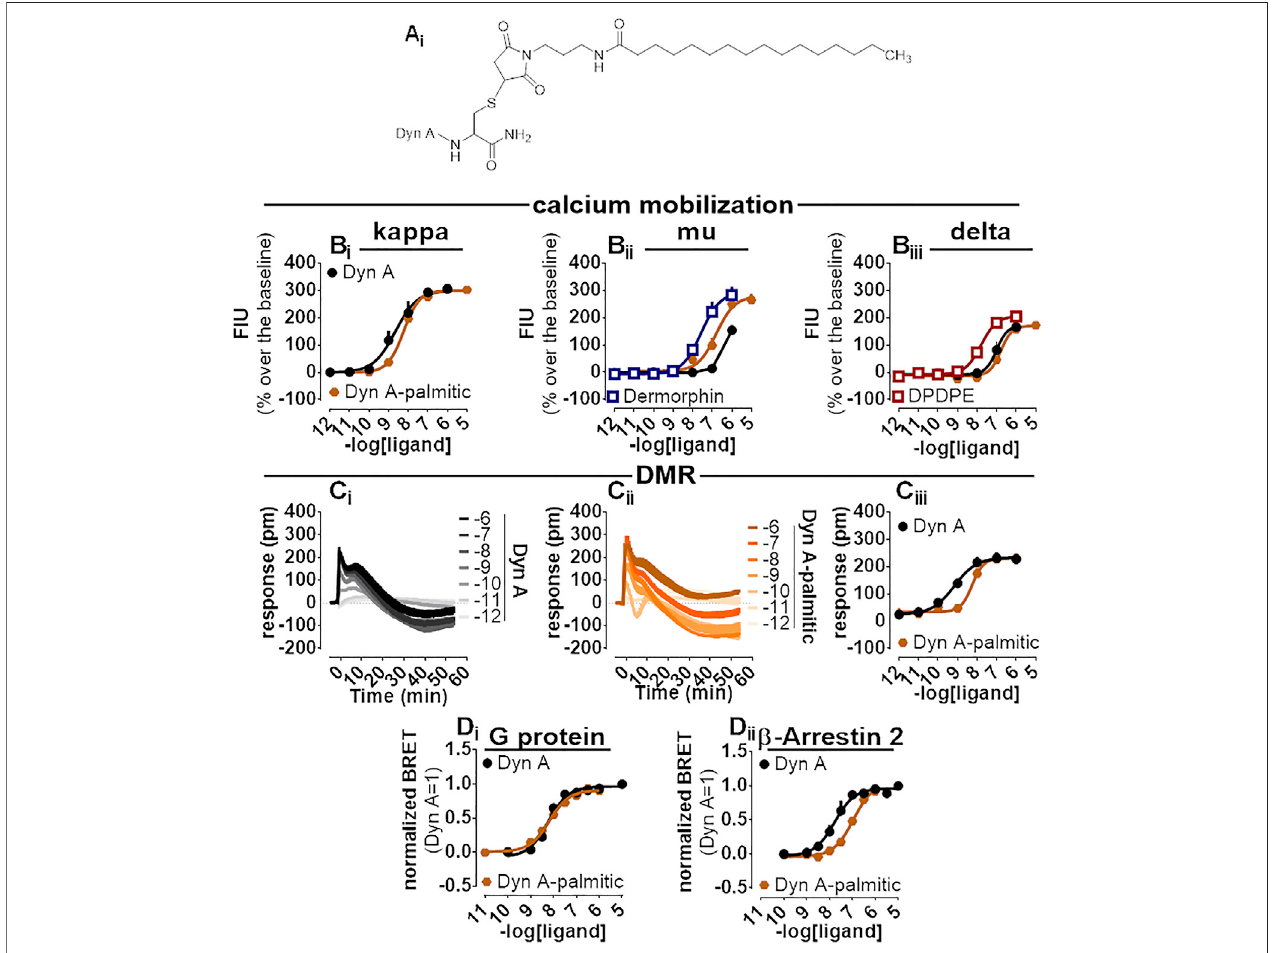
FIGURE 6 | Pharmacological characterization of Dyn A-palmitic. Molecular structure (A i ) . Calcium mobilization experiments in CHO cells stably expressing the humankappa (B i ) ,mu (B ii ) ,anddelta (B iii ) opioidreceptorsandchimericGproteins.Concentration-responsecurvestoDynAandDynA-palmitic.AveragedDMRtraces obtained in CHO cells stably expressing the human kappa opioid for increasing concentration of Dyn A (C i ) and Dyn A-palmitic (C ii ) , with corresponding concentration- response curves (C iii ) . Concentration response curves to Dyn A and Dyn A-palmitic performed with a BRET assay on SH-SY5Y cells stably expressing the human kappa opioid-RLuc tagged receptor together with either the G β 1 -RGFP (D i ) or the β -Arrestin 2-RGFP fusoprotein (D ii ) . Data are mean +sem of three to six independent experiments performed in